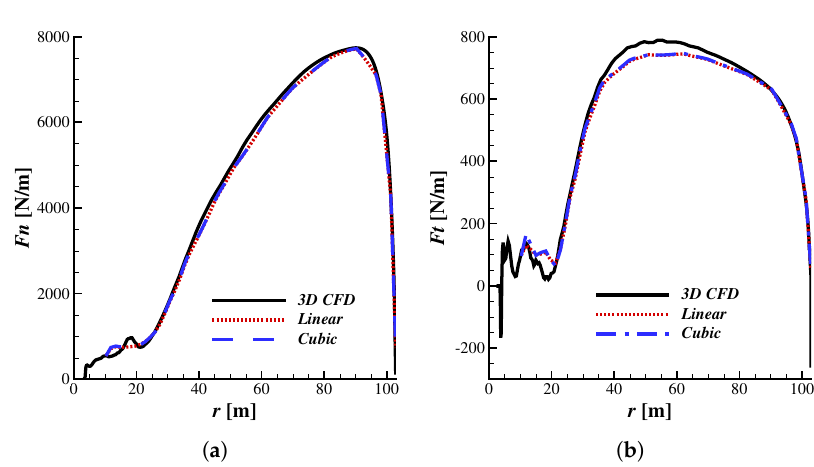
Figure 12. Effects of interpolation order of the polar data on the sectional force distributions along the blade radius; ( a ) normal force, ( b ) tangential force.